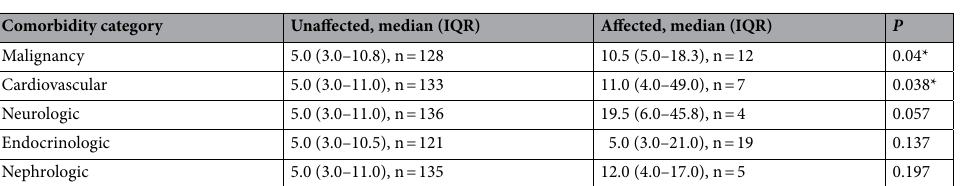
Table 2. Comparison of duration from symptom onset to diagnosis in patients with Guillain–Barre syndrome classified by particular comorbidity categories. IQR, Interquartile ranges. * p <